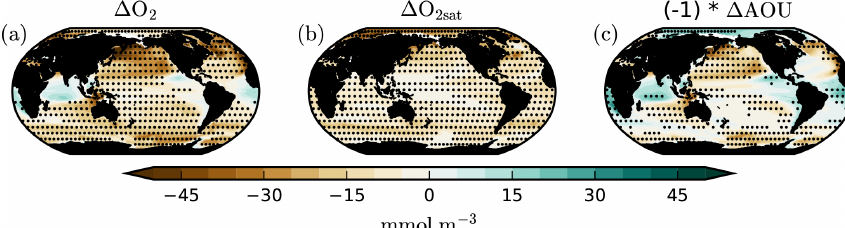
Figure 3. Change in subsurface oxygen saturation and apparent oxygen utilisation under SSP5-8.5. CMIP6 multi-model mean changes in (a) subsurface dissolved O 2 concentration (averaged between 100 and 600m ; mmolm − 3 ), (b) subsurface O 2 saturation (O 2sat ), and (c) subsurface apparent oxygen utilisation (AOU) in 2080–2099 of SSP5-8.5 relative to 1995–2014. Stippling designates robustness, as defined by at least 80% model sign agreement (only a subset of CMIP6 models were